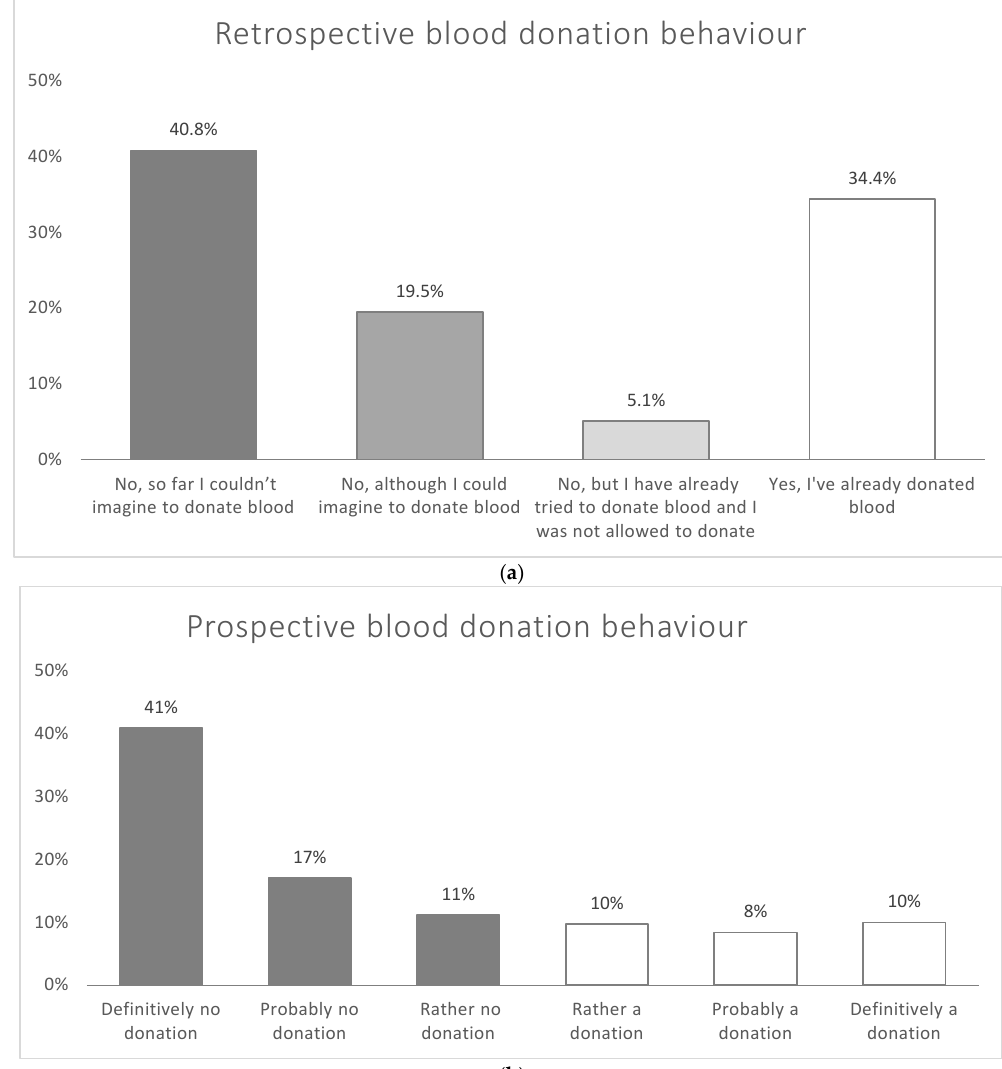
Figure 1. ( a ) Self-reported retrospective (lifetime) blood donation behaviour—results for total sample ( n = 2531, weighted). Absolute frequencies and cumulative percentages vary as a function of the amount of missing data for each variable. ( b ) Self-reported prospective (12 months) blood donation behaviour—results for total sample ( n = 2531, weighted). Absolute frequencies and cumulative percentages vary as a function of the amount of missing data for each variable.